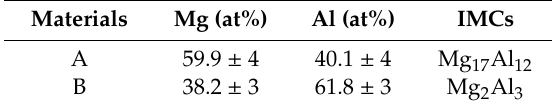
Table 2. Chemical composition in different regions of Figure 6a via EDS analysis.